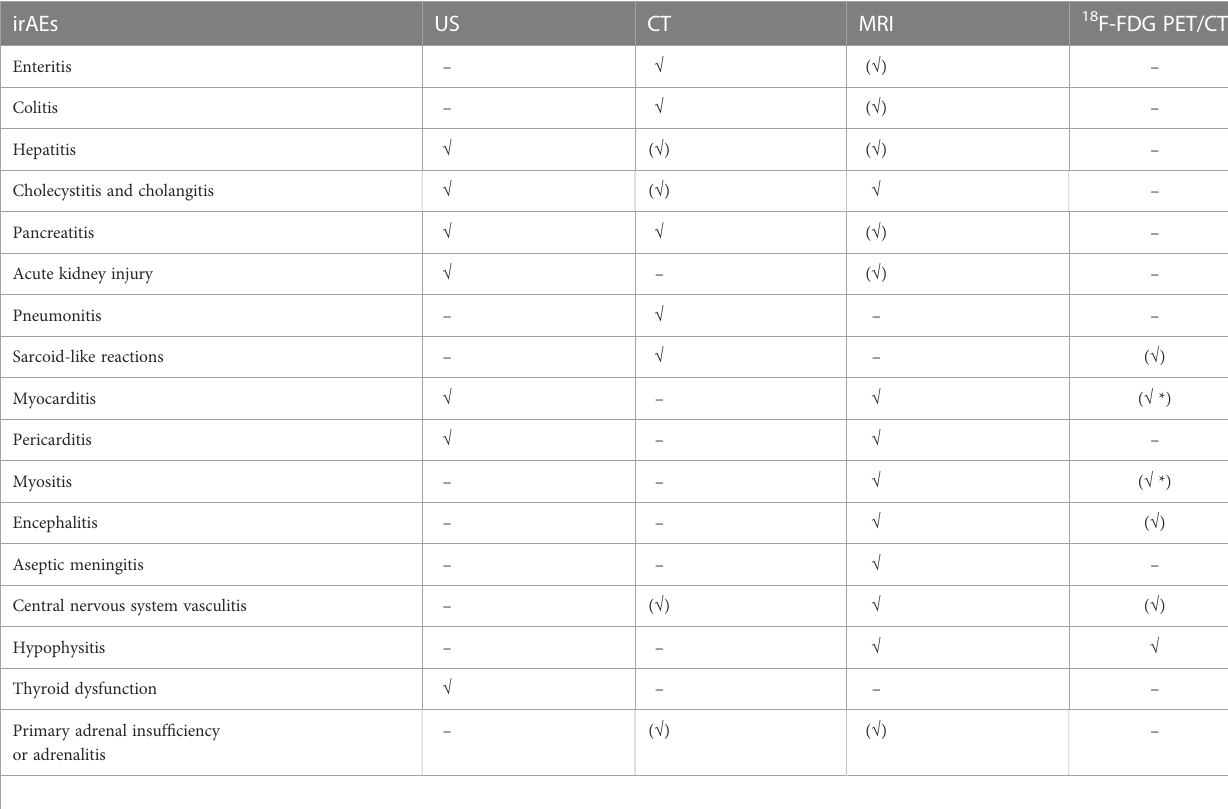
TABLE 2 Recommended imaging to be prescribed in the presence of suspected immune-related adverse events